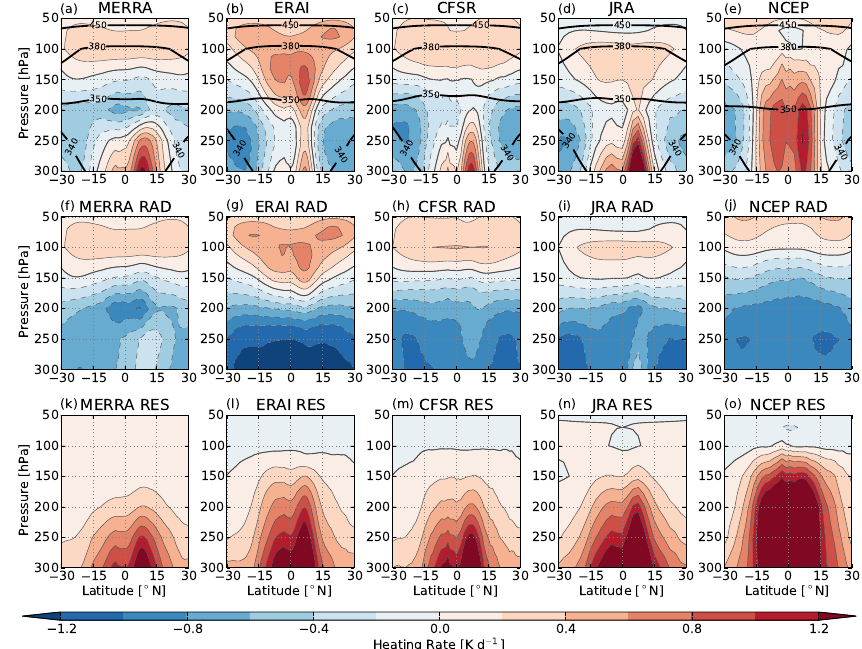
Fig. 2. Top row: zonal mean total diabatic heating averaged over the period 2001–2010 according to the (a) MERRA, (b) ERAI, (c) CFSR, (d) JRA, and (e) NCEP reanalysis data sets. The 340, 350, 380, and 450K isentropic surfaces from each reanalysis are shown as black contours. Middle row: zonal mean radiative components of diabatic heating averaged over the period 2001–2010. Bottom row: zonal mean residual components of diabatic heating averaged over the period 2001–2010. Residual diabatic heating includes all diabatic heating due to non-radiative physics (moist physics, turbulent mixing, etc.).